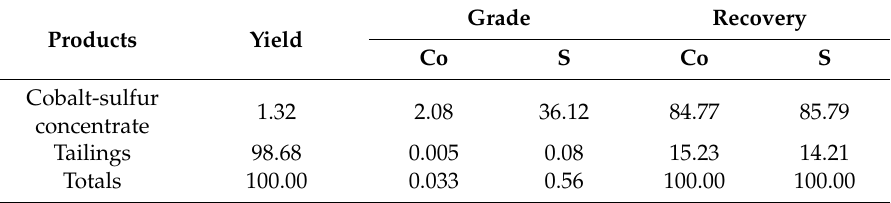
Table 6. Results of the whole flotation test flowsheet of recovering cobalt (%).